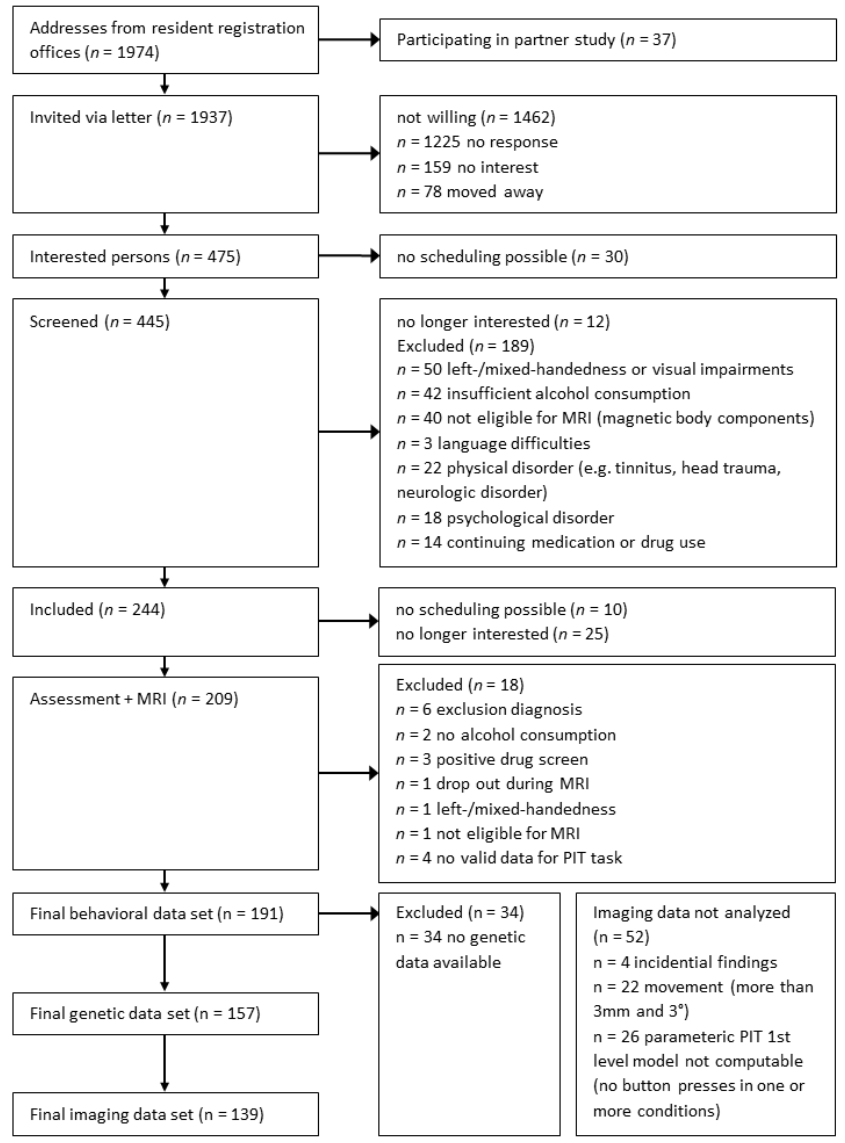
Figure 1. Recruiting and exclusion procedure leading to the final behavioral, genetic and imaging datasets. MRI: magnetic resonance imaging; PIT: Pavlovian-to-instrumental transfer. Participants performed the instrumental task now with CS tiling the background (see Figure 2C). Note that the instrumental task was independent of the value of the background stimulus. No outcomes were presented, but participants were instructed that their choices still counted towards the final monetary outcome. The pairings of CS in background und shell in foreground were counterbalanced with each combination showing three times, resulting in 90 trials. Forced choice task. Finally, participants chose one of two CSs (Figure 2D). All possible CS pairings were presented three times in randomized